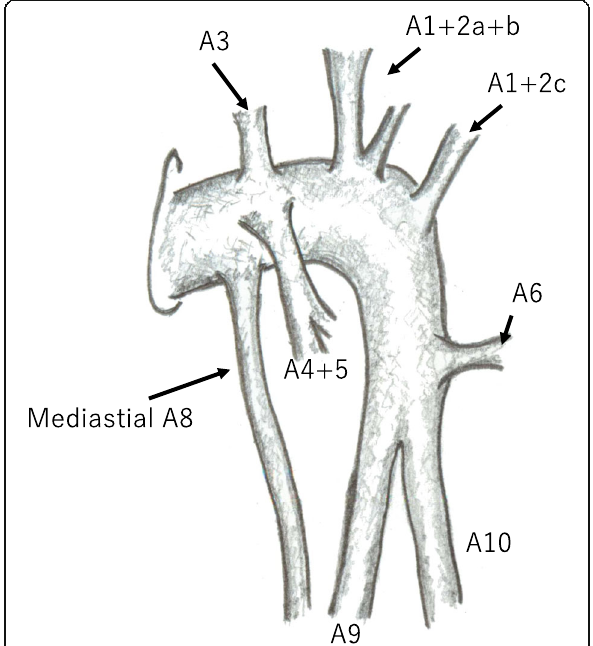
Fig. 3 A schema of left pulmonary artery and branches. Left main pulmonary artery gives off mediastinal A4+5 and A8. Basal pulmonary artery supplies S9 and